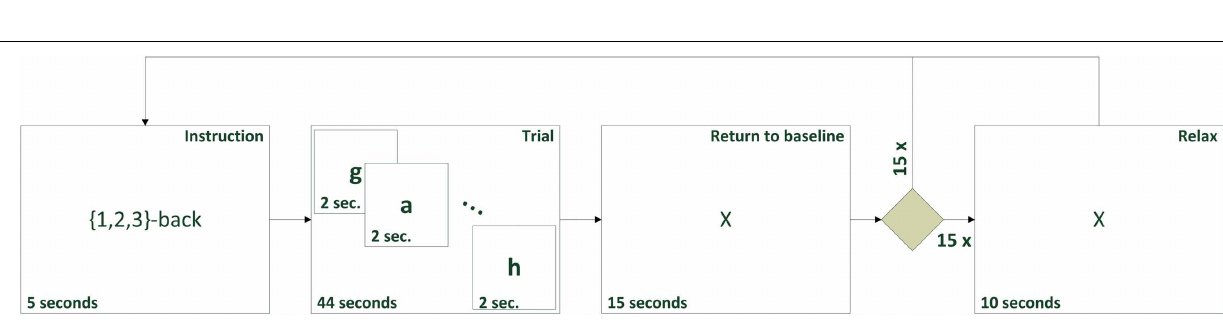
FIGURE 2 | Experimental design for n -back